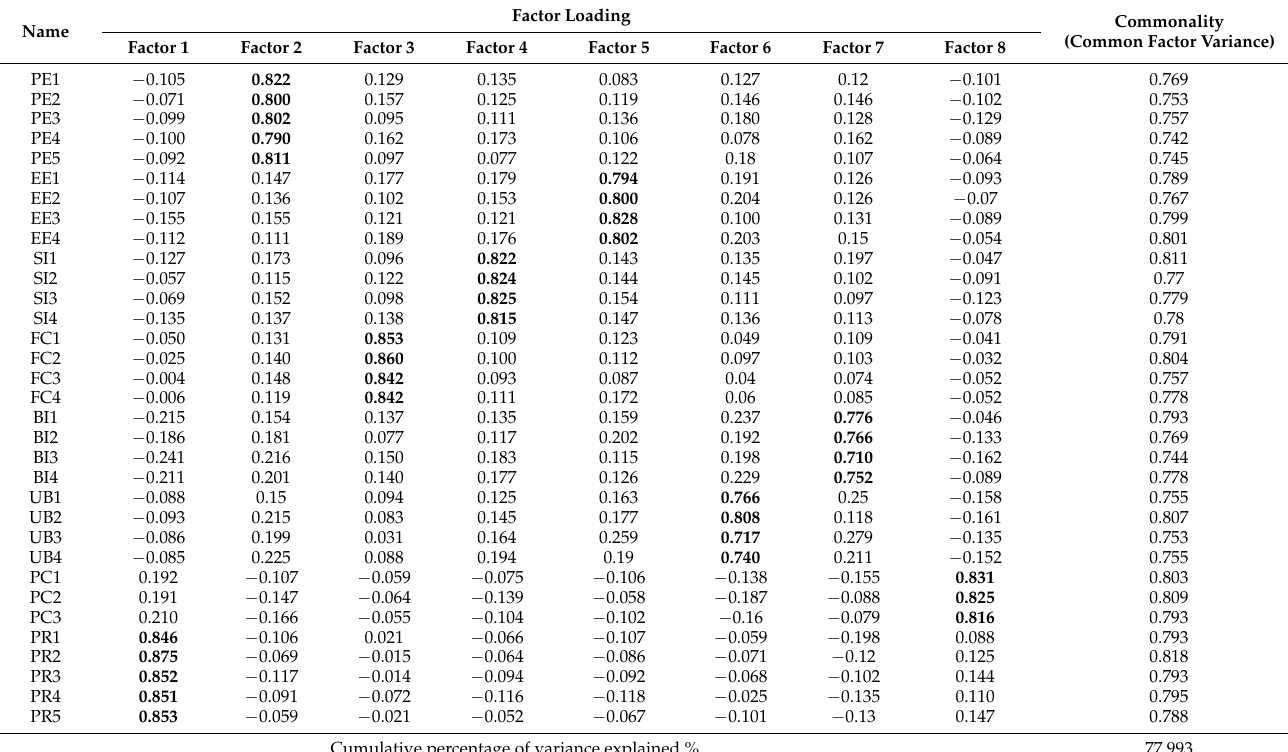
Table 5. Factor loadings